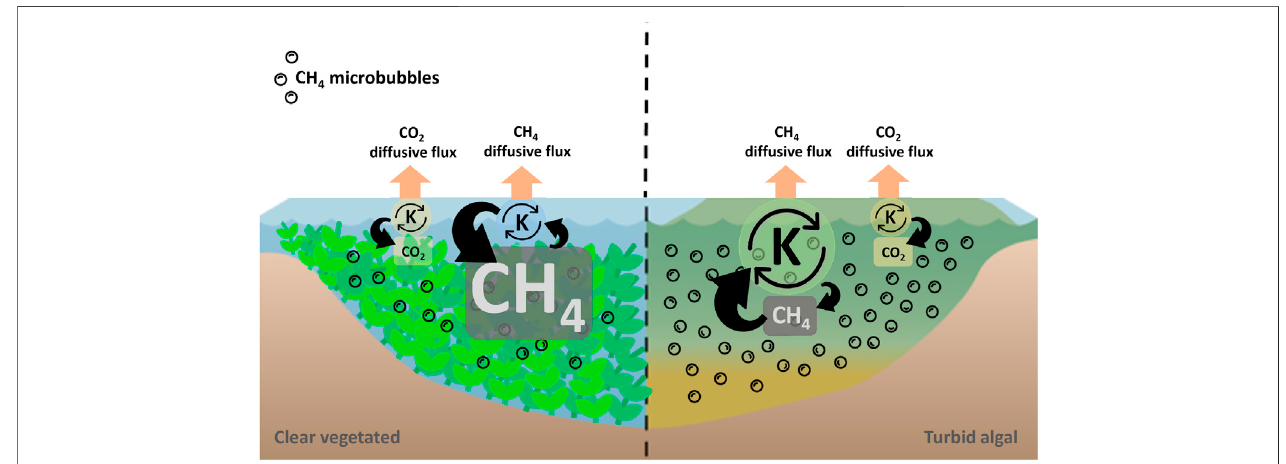
FIGURE 6 | Conceptual scheme of a plausible explanation for the observed results: states had similar mean annual CO 2 diffusive fl ux, p CO 2 and k 600 CO 2 . States also had similar mean annual CH 4 diffusive fl ux, but clear vegetated lakes had higher mean annual p CH 4 than turbid algal lakes. This difference in mean annual p CH 4 between states was explained by a lower mean annual k 600 CH 4 in clear vegetated lakes, where submerged vegetation reduced wind induced turbulence in the water column, therefore diminishing CH 4 microbubbles formation. Overall, p CO 2 is controlled by k 600 CO 2 in both states, as expected, but regulation of CH 4 is more complex: in clear lakes p CH 4 ismainly controlled by gasexchange(k 600 CH 4 ) but there isalso aminor control of p CH 4 over k 600 CH 4 , re fl ected in aconsistently elevated k 600 CH 4 relative to k 600 CO 2 butthatisindependentof p CH 4 and wind.Inturbidlakes, apparent k 600 CH 4 ismainlycontrolled bywindand secondarily by p CH 4 through wind-driven